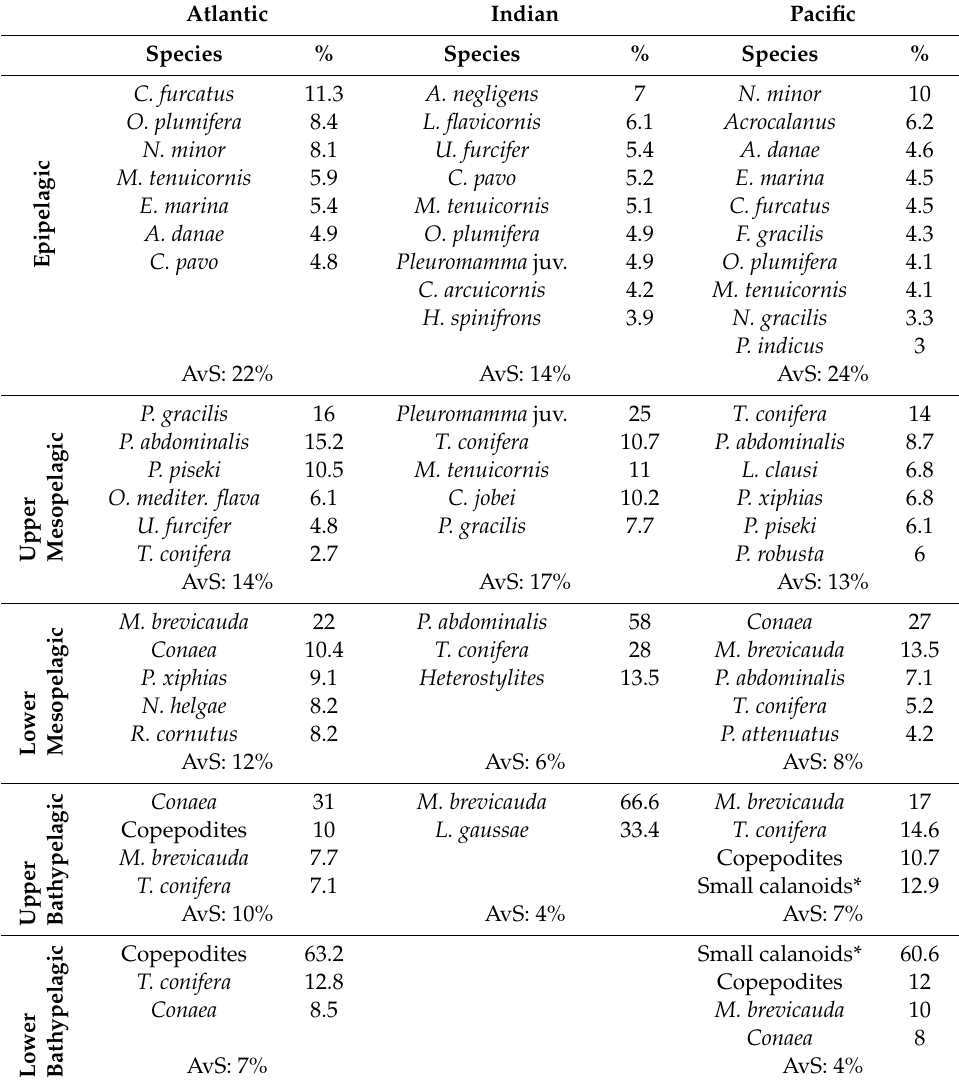
Table 4. Contribution of main copepod taxa (%) to the strata in the three Oceans: Atlantic, Indian, and Pacific. Calanoid juveniles (as Copepodites). Small calanoids* ( Paracalanus, Clausocalanus, Calocalanus, and Acartia ) as possible contaminants. AvS stands for Average Similarity.